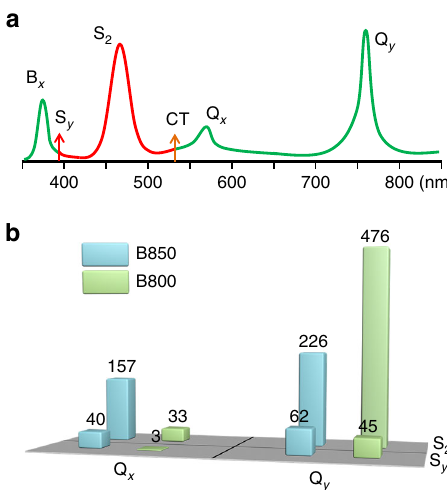
Fig. 7 Absorption spectrum and electronic coupling strength for a carotenoid – chlorophyll complex. a Calculated absorption spectrum of the rhodopin glucoside-B800 complex as linked by the dashed line in Fig. 2b. CT denotes the charge-transfer state. Oscillator strengths of the S y and CT states are very weak. Here arrows are used to indicate their positions. b Electronic coupling strengths (in cm − 1 ) for the energy transfer passways from the S 2 and S y states to the Q x and Q y states in the rhodopin glucoside-B850 and rhodopin glucoside-B800 pairs as linked by dashed lines in Fig. 2b. Distances between the centers of corresponding rhodopin glucoside and B850/B800 molecules are given in Fig.